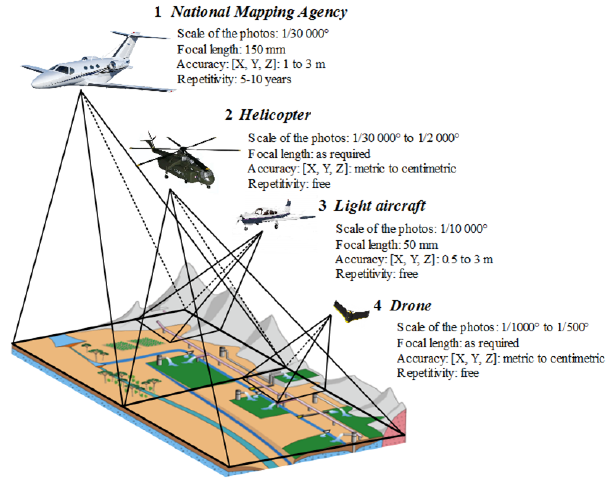
Figure 1. Sketch representing recording scale of Earth’s surface ac- cording to Henry